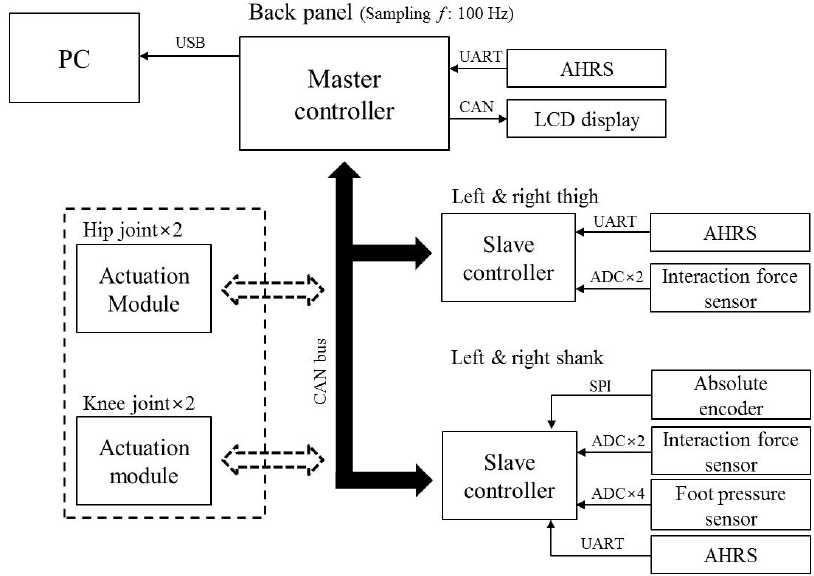
Figure 6. Schematic of the control system.